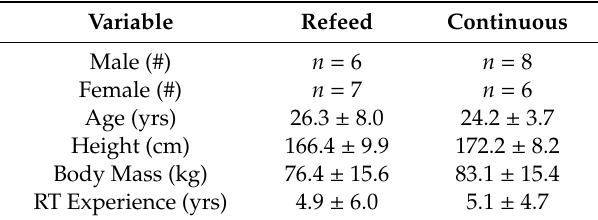
Table 1. Characteristics of participants at baseline (mean ±